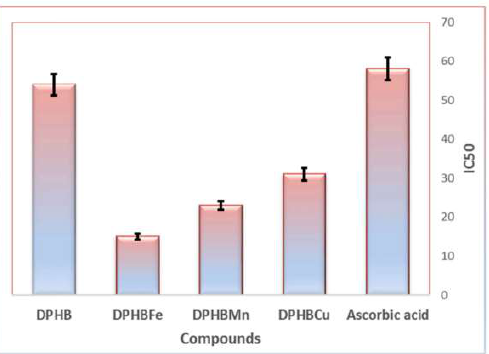
Figure 8. The inhibition performance of DPPH radical for DPHP (67) ligand and its complexes (68–70). Reproduced from the permission of ref. [149].